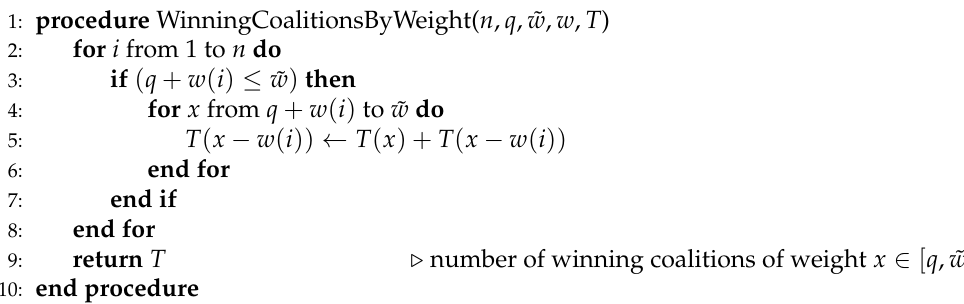
Algorithm 2 Generalized counting of number of winning coalitions per weight